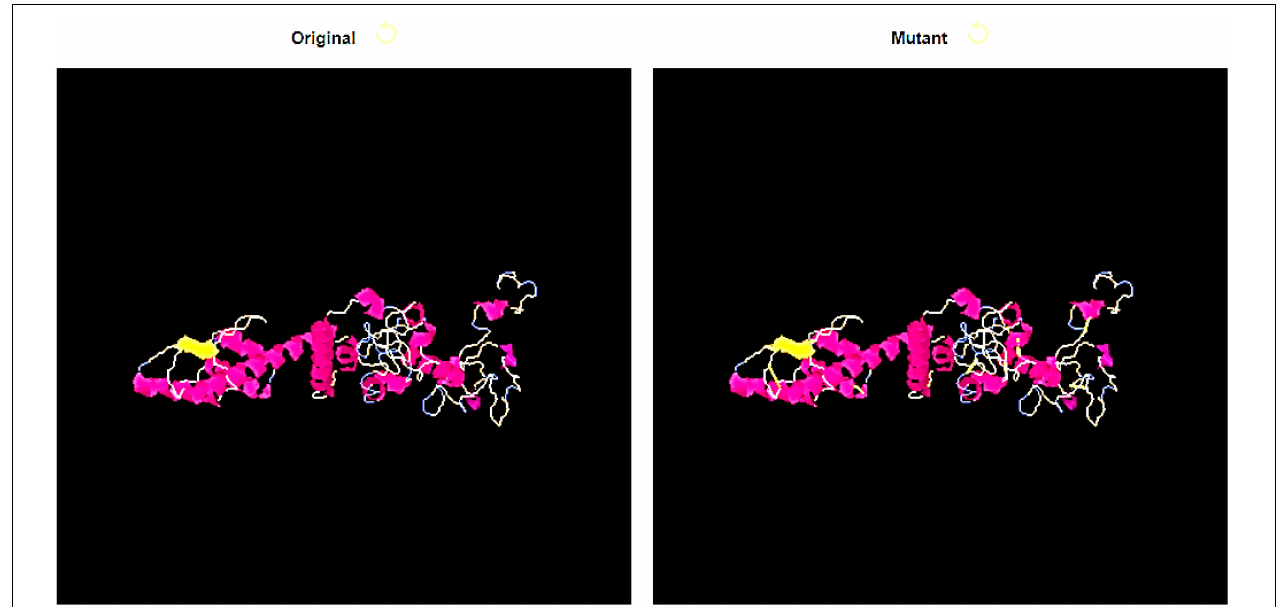
FIGURE 8 | Disulfide engineering of the designed vaccine molecule. Both wild (left) and mutated structure (right) is shown. The yellow sticks in mutated structure are residues replaced with cysteine.